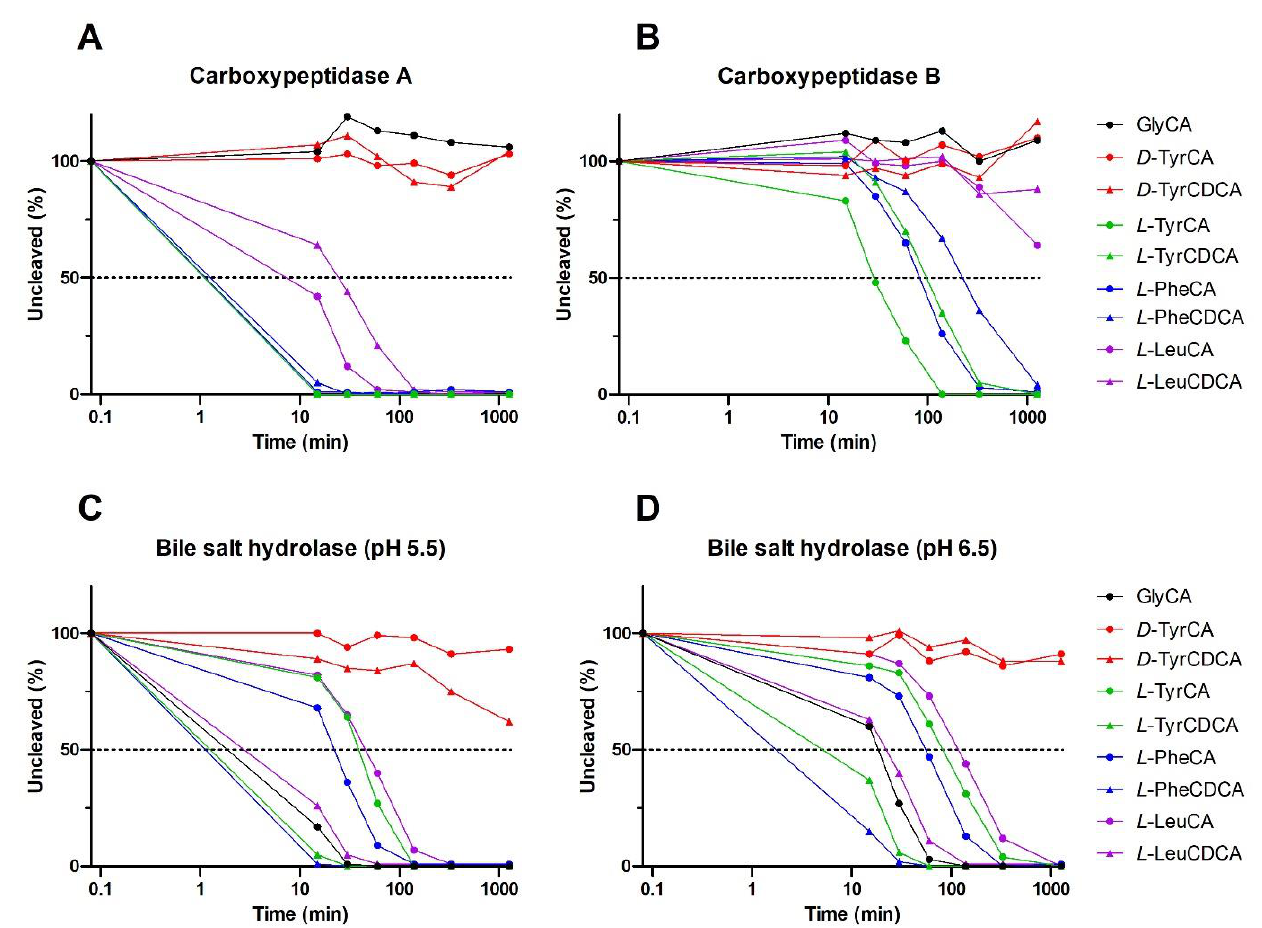
Figure 3. MBSCs are deconjugated by digestive and microbial enzymes in vitro. A mixture of the indicated bile salts (0.5 nmol each) was incubated at 37 °C with 5 units of either bovine pancreatic carboxypeptidase A ( A ), porcine pancreatic carboxypeptidase B ( B ) or bile salt hydrolase from Clostridium perfringens ( C , D ) in 0.5 mL of recommended buffers. Reactions were stopped at the indicated time points by transfer of a 50 µ L aliquot to tubes containing 150 µ L of HPLC-grade methanol, followed by further work-up for LC-MS analysis of remaining conjugate and liberated parent bile salt. Cleavage is expressed relative to the starting amount.